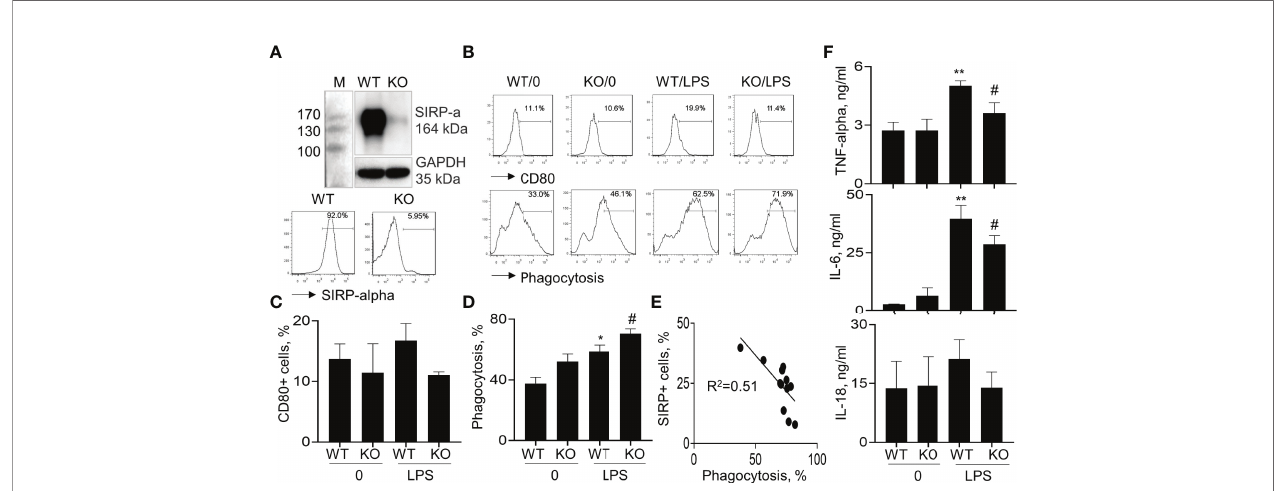
FIGURE 5 | Lack of SIRP-alpha expression suppressed activation, expression of pro-in fl ammatory cytokines and improved phagocytosis of bone marrow-derived macrophages (BMDMs). (A) Western blot (upper panel) and fl ow cytometry (lower panel) analysis for the expression of SIRP-alpha in WT and KO mice-derived BMDMs. Representative blot and histogram of fl ow cytometry. (B) BMDMs from WT and KO mice were treated with or without 500 ng/ml LPS for 24 hours. Flow cytometry analysis for the expression of CD80 and macrophage phagocytosis of PKH26-labeled apoptotic NPs at a ratio of 2:1 (apoptotic cells: macrophages) for